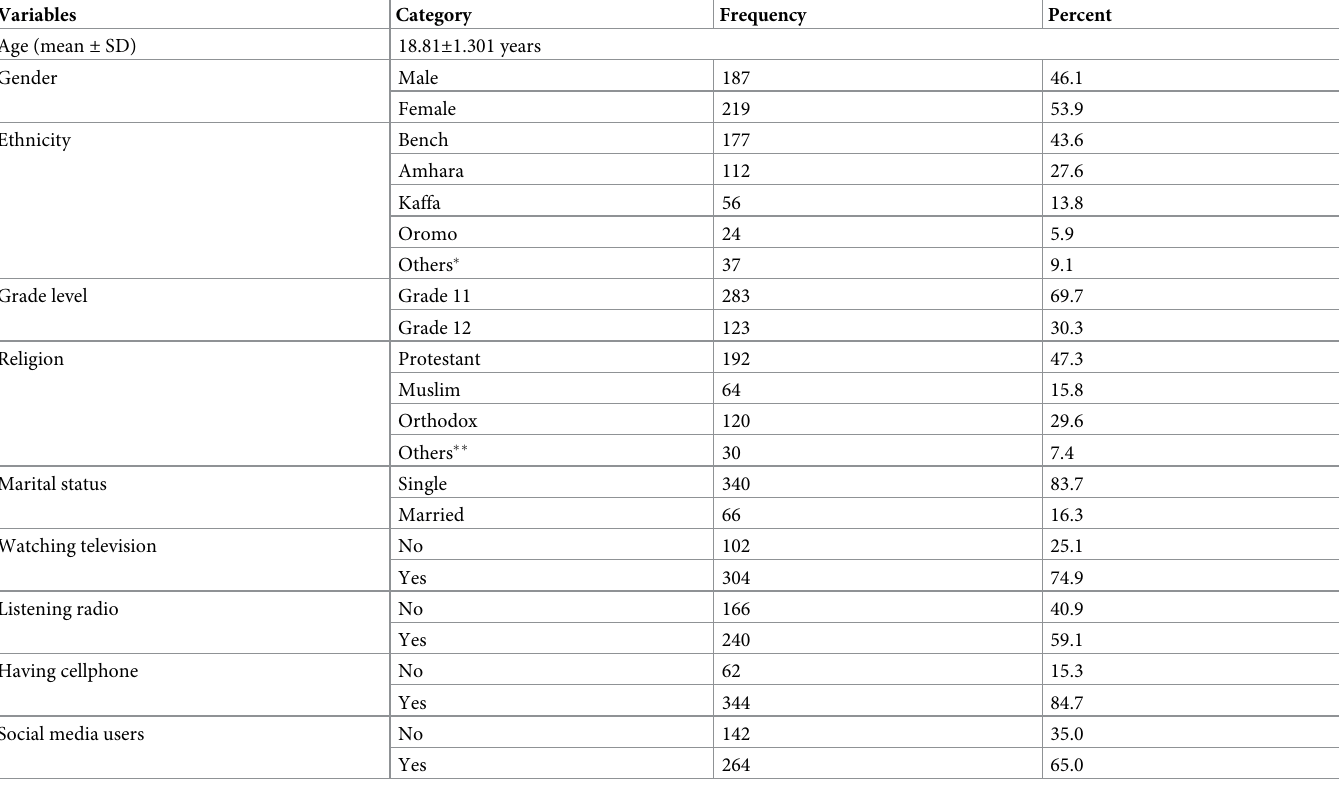
Table 1. Socio-demographic status of preparatory school students at Mizan-Aman town, 2021 (n = 406). Variables